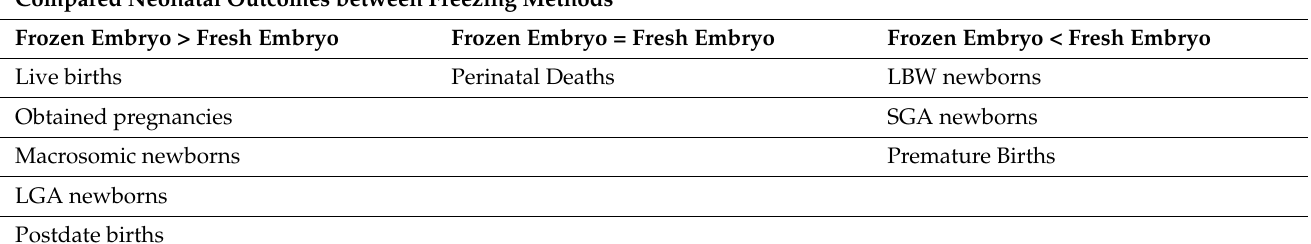
Table 2. Comparison of neonatal outcomes between frozen embryo and fresh embryo methods according to the